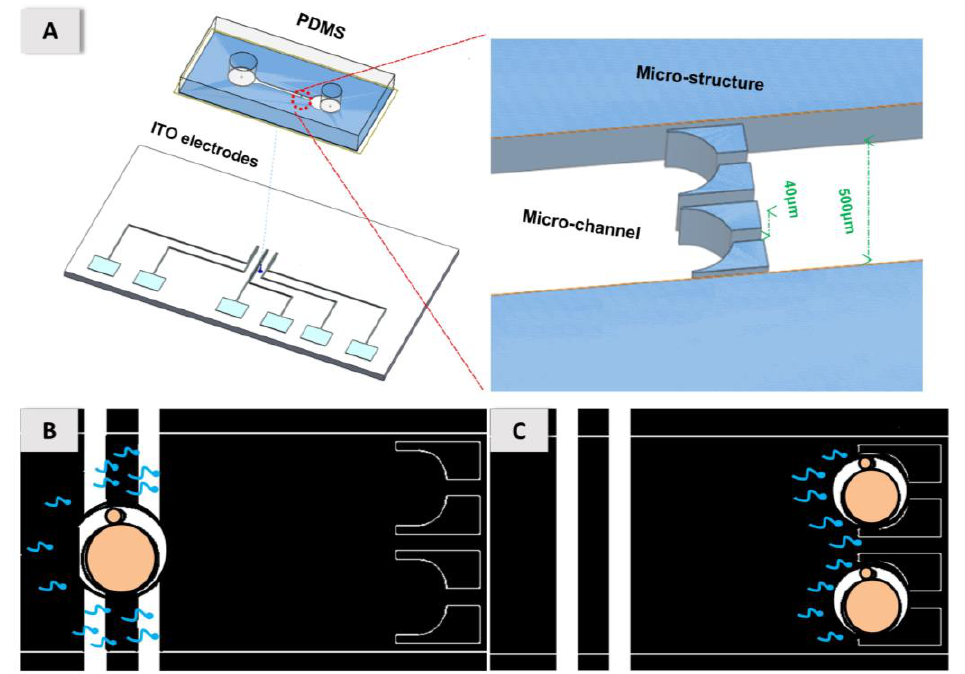
Figure 1. Fabrication of the designed DEP microfluidic biochip; ( A ) actual device of size 5 cm × 3 cm. Bonding of PDMS (microchannel and micro-structures) with the ITO electrode chip. ( B ) The concept of the experiment is that the mouse oocytes and sperm become trapped on the electrodes for about 1 min with the p-DEP. ( C ) Co-incubated 1 h in the micro-structures for natural insemination. (a) ITO-glass electrode chip